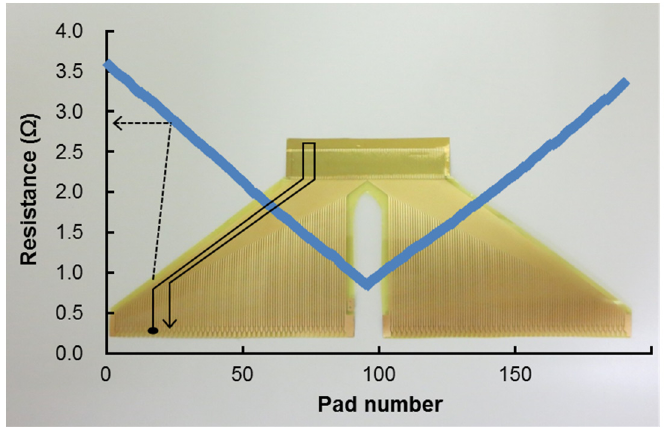
Figure 9. Resistance of the film-type